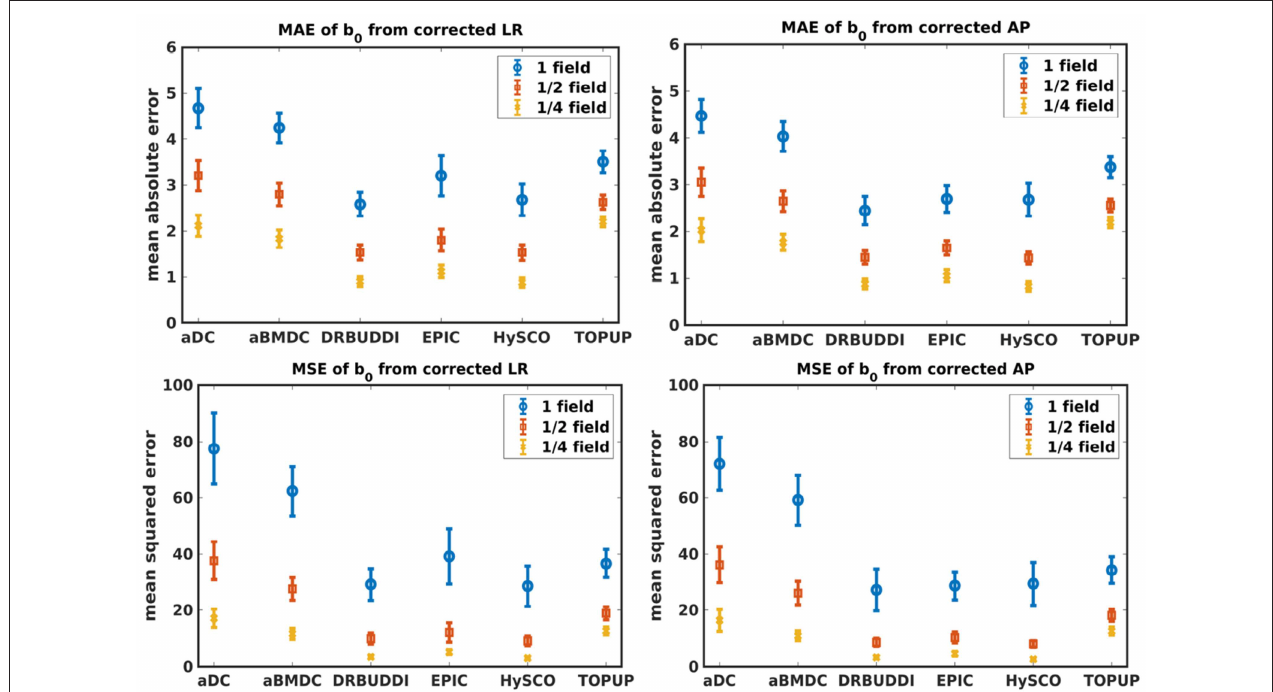
FIGURE 5 | MAE (Top) and MSE (Bottom) of b 0 for five simulated HCP subjects using the six methods. The error bars represent standard deviation over subjects. Correction was carried out for LRRL (Left) and APPA (Right) pairs, respectively. Three levels of susceptibility distortion were simulated.